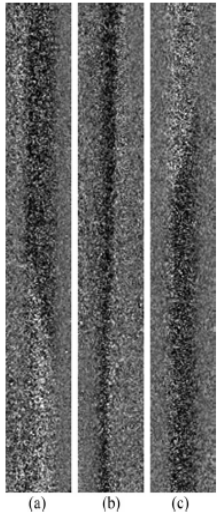
Figure 7. Fe-rich microwire. Torsion-stress-induced transformation of surface domain structure ( a ) 34 π rad·m − 1 ; ( b ) 27 π rad·m − 1 ; ( c ) − 7 π rad·m − 1 . Reprinted with permission from [92].